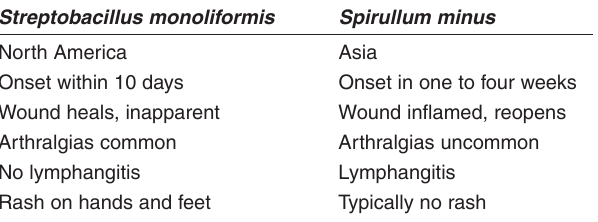
TABLE 1 Clinical features of rat bite